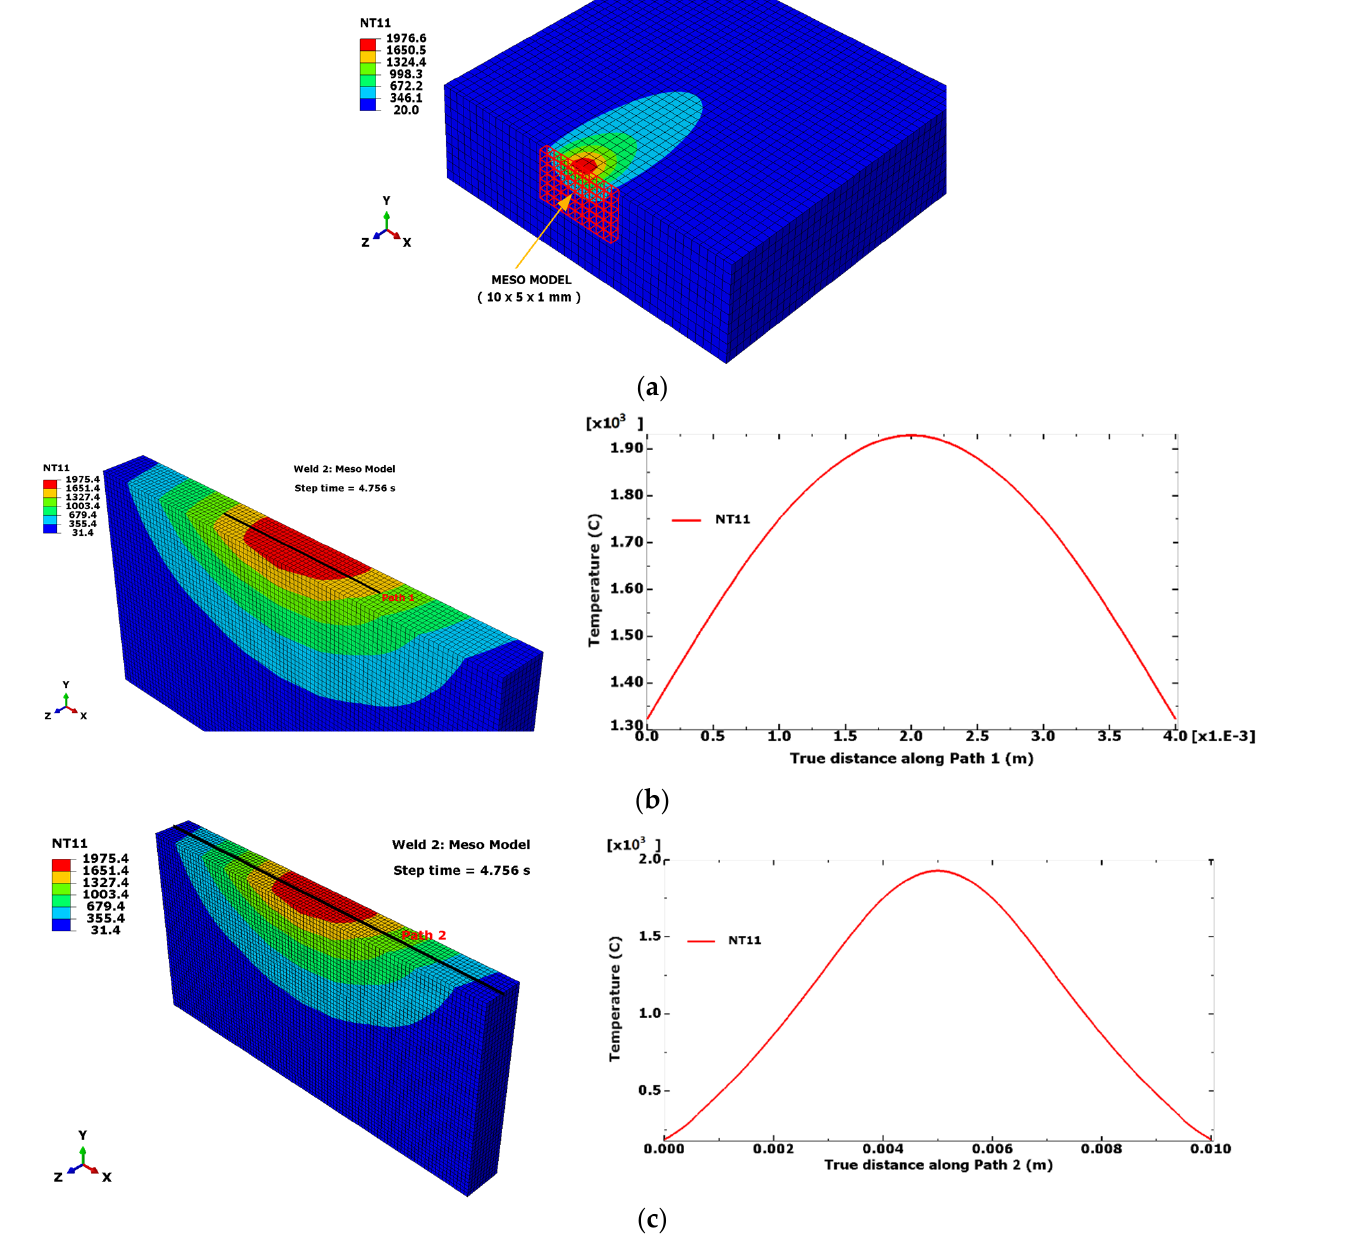
Figure 6. ( a ) Description of the meso model (10 × 5 × 1 mm) constructed from a macro model (40 × 10 × 75 mm) using the Shape → Cut → Extrude options available in ABAQUS CAE; ( b ) temperature distribution along Path 1; and ( c ) temperature distribution along Path 2. Values obtained at the step time 4.756 s. Element size = 100 µ